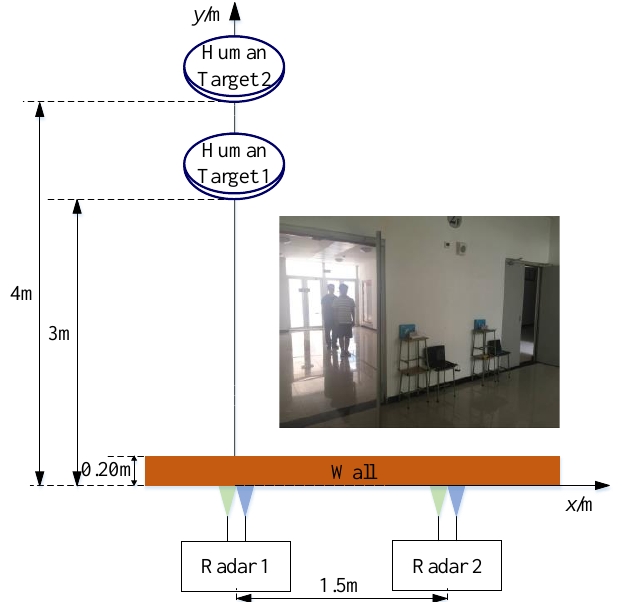
Figure 8. Photograph and geometry of Experiment 1.2.